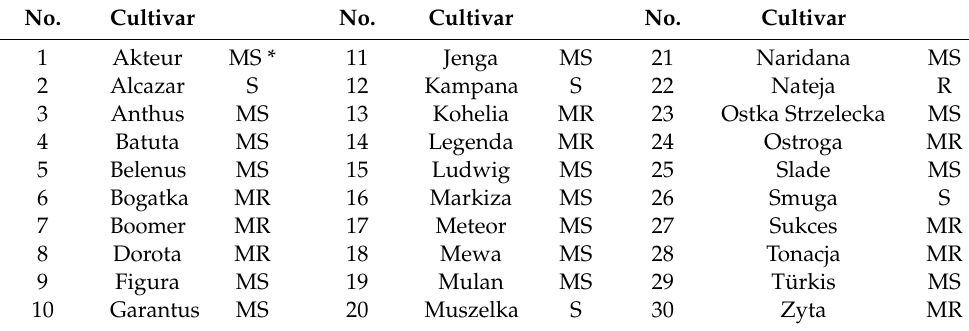
Table 1. List of winter wheat cultivars used in this